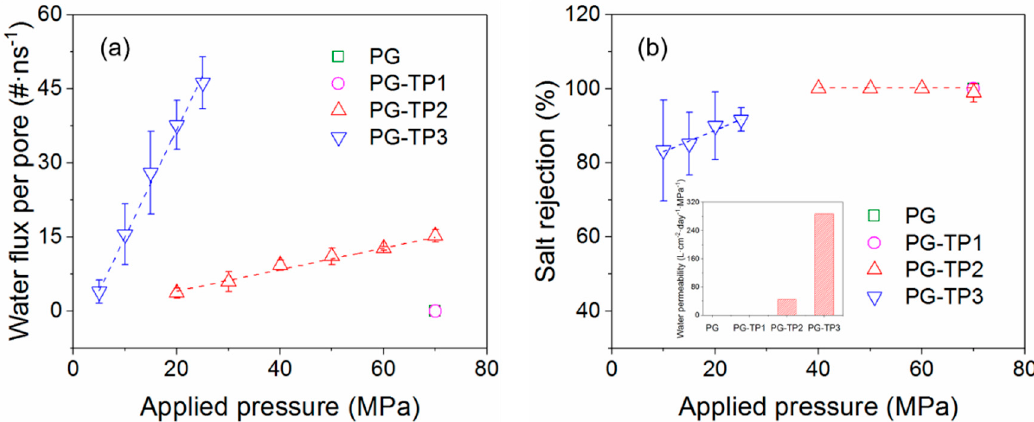
Figure 6. Water flux and salt rejection of porous graphene (PG) membranes. ( a ) Water flux and ( b ) salt rejection as a function of applied pressure, inset shows water permeability of each PG membrane. Lines serve as guides to the eyes.